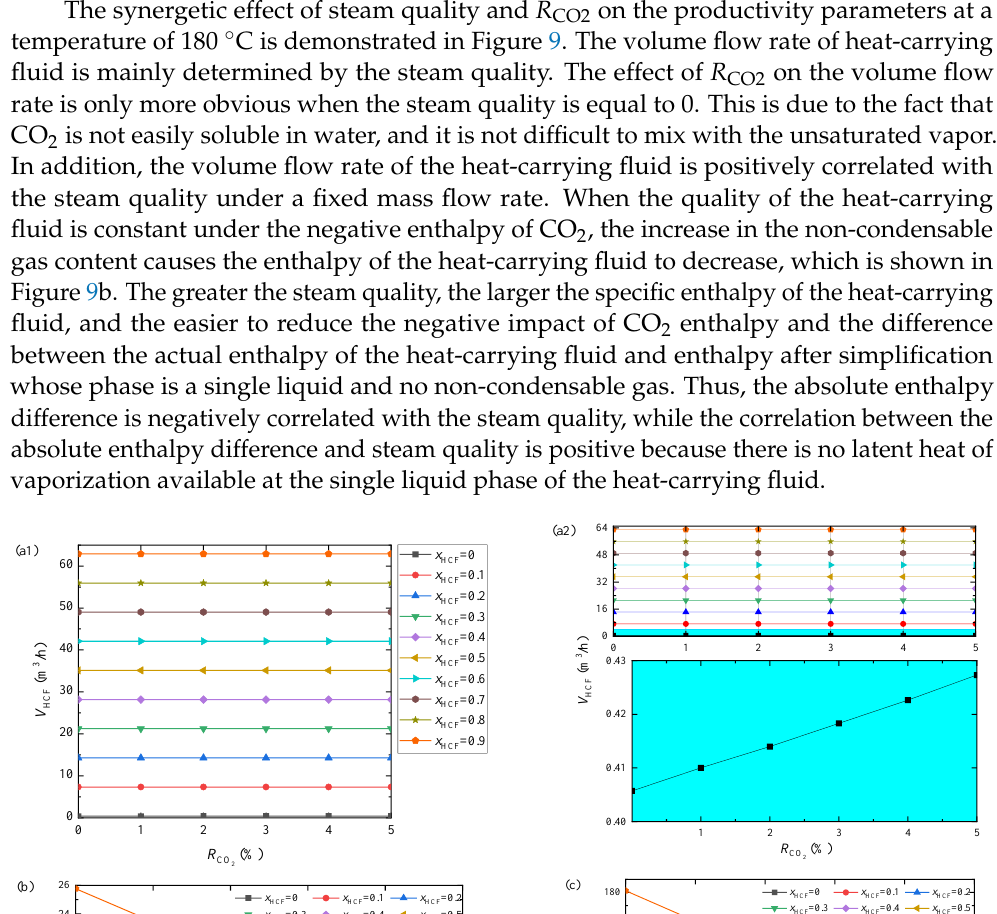
Figure 8. Variation curves of productivity parameters of heat carrier with t HCF under different R CO2 : ( a ) volume flow rate, ( b1 , b2 ) enthalpy and ( c ) absolute enthalpy difference.